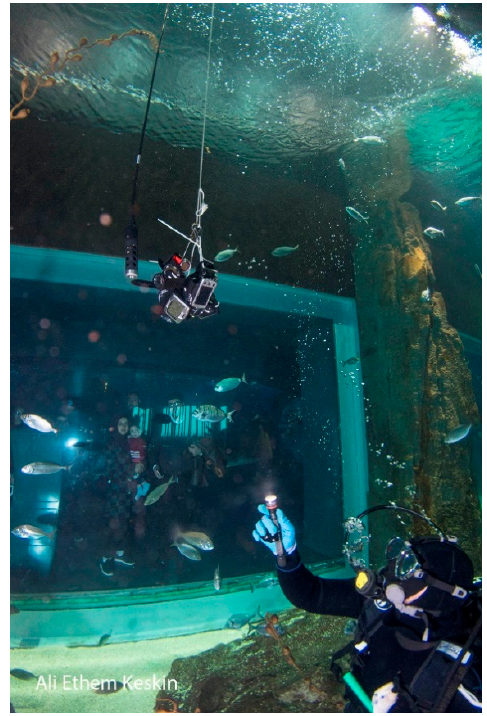
Figure 2. Diver checking the proper booting of the dive computers.